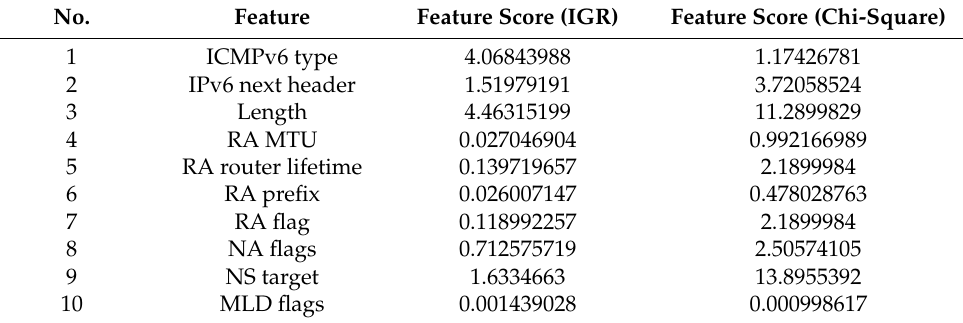
Table 4. Scores of each feature using IGR and chi-square